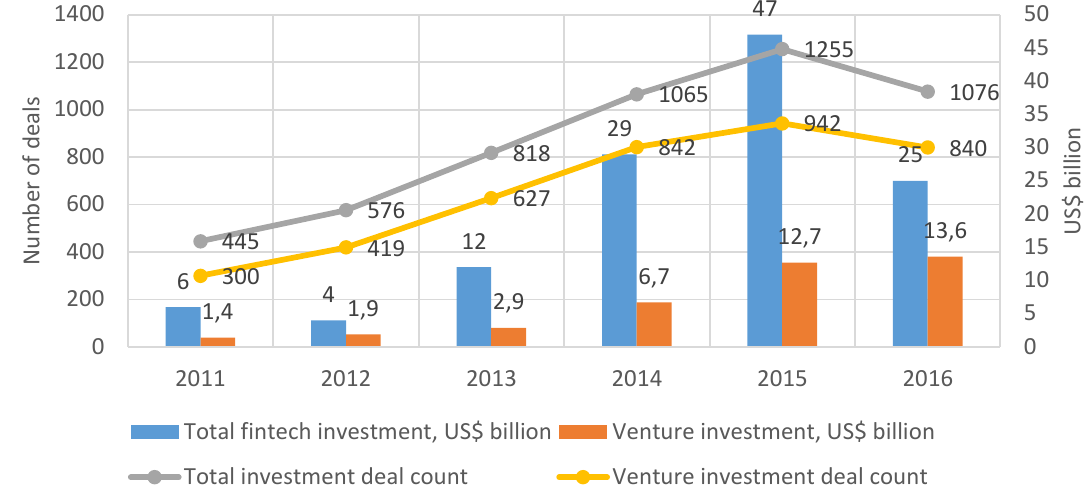
Figure 2. Total and venture investments into global FinTech sector in 2011–2016